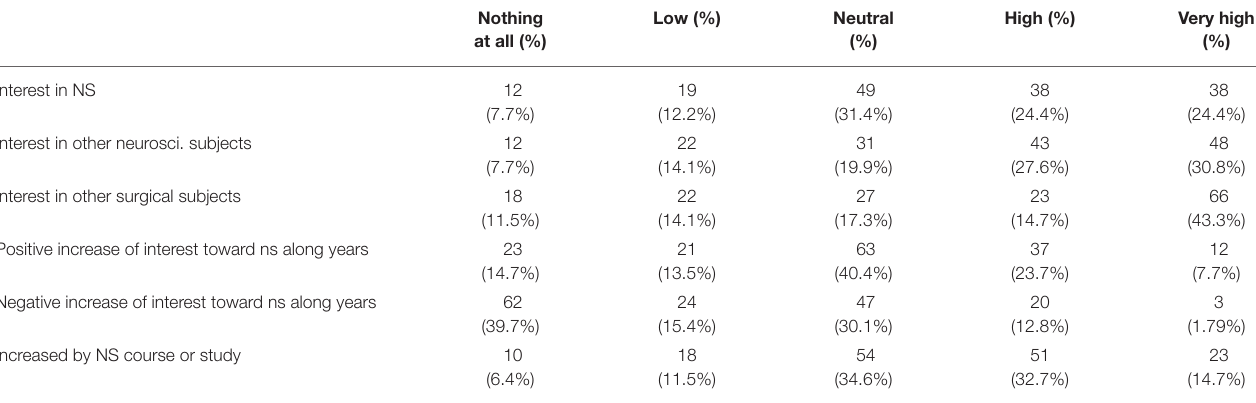
TABLE 2 | Personal interest in neurosurgery and similar subjects.